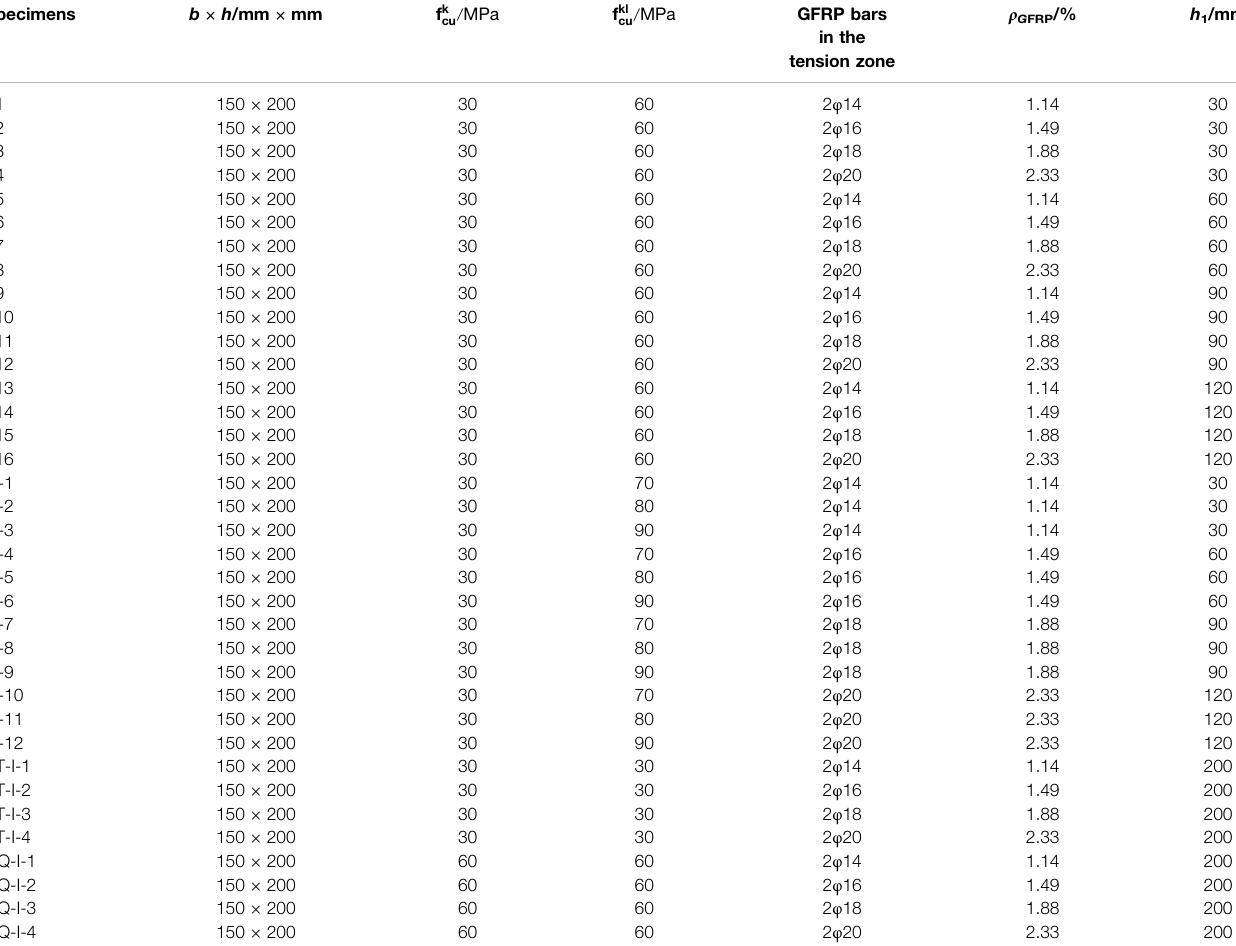
TABLE 1 | The main parameters of specimens. Specimens